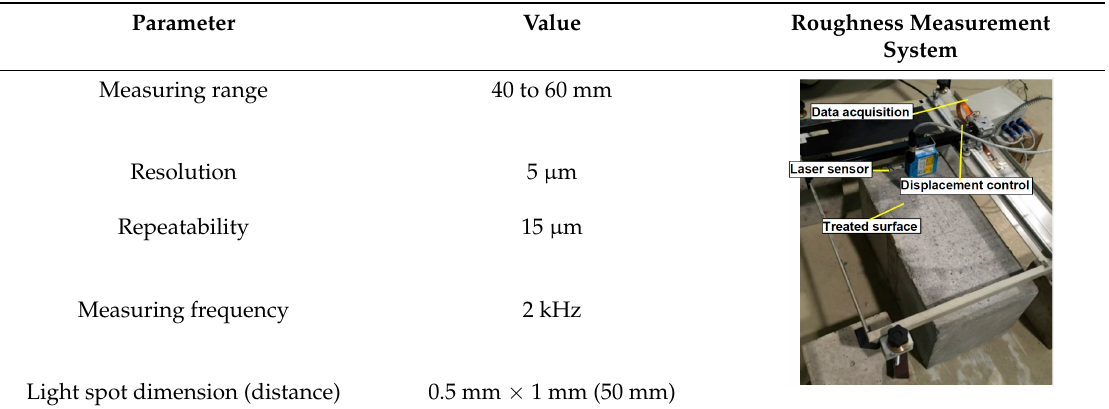
Table 1. Properties of laser sensor SICK OD2—N50W10U0 and roughness measurement system.